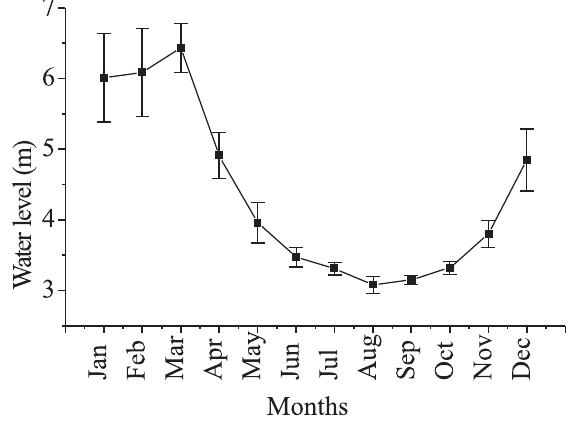
Fig. 1. Monthly mean variation of the rio Cuiabá water level obtained at the City of Santo Antônio do